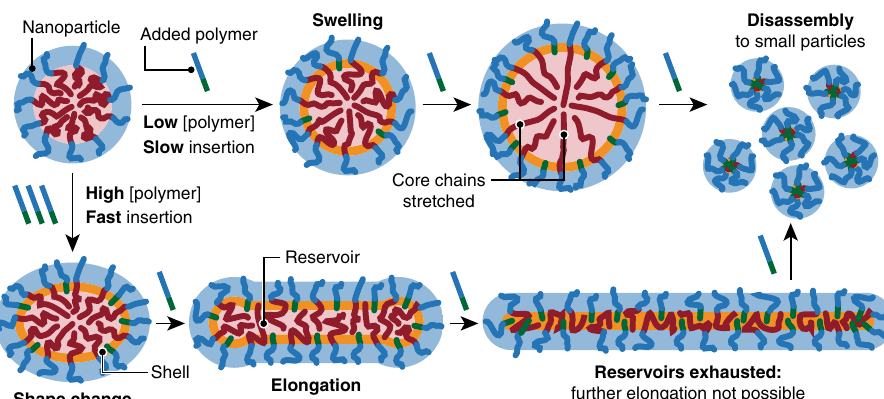
Fig. 6 Proposed MORPH pathways. Schematic illustrations at low (upper pathway) and high (lower pathway) concentrations of the added